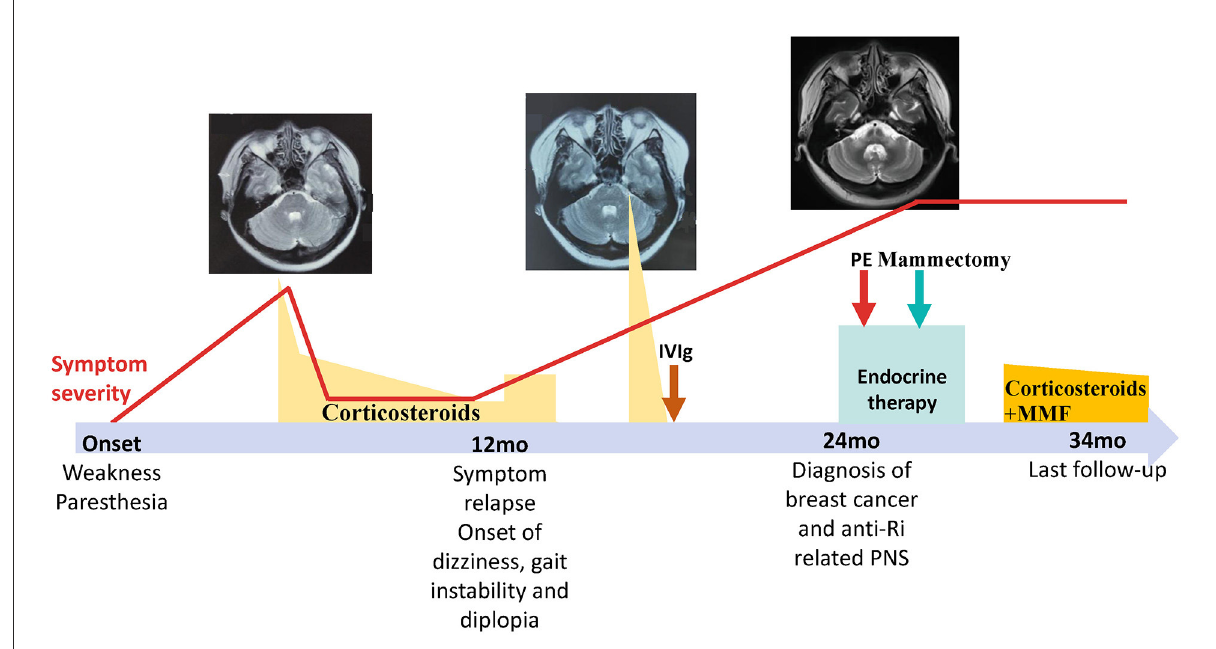
FIGURE2 The timeline of the present